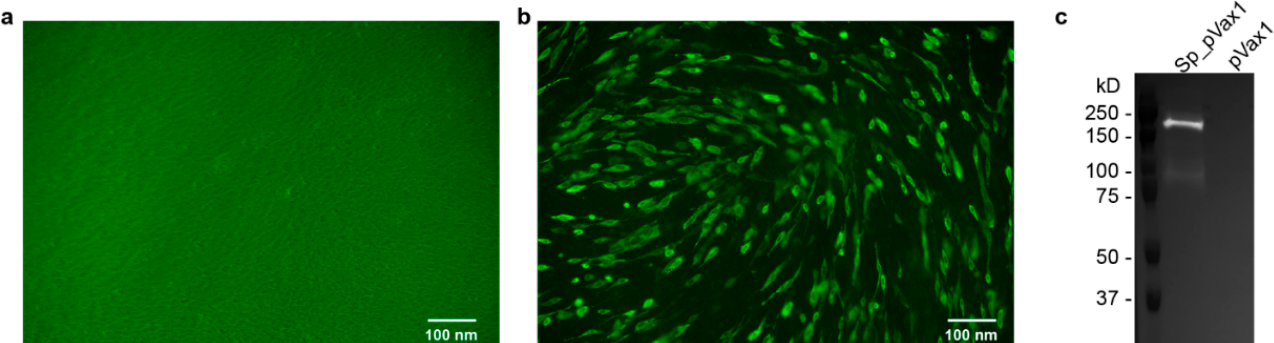
Figure 1. Sp_pVax1 and pVax1 Plasmid Expression. Immunofluorescence assay (IFA) on BHK-21 cells transfected with ( a ) pVax1 or ( b ) Sp_pVax1. Cells were permeabilized and probed with primary anti-V5 antibody and secondary fluorescent antibody at 24 h post transfection to visualize spike protein-positive cells. BHK cell lysate was collected at 24 h post transfection and evaluated via ( c ) western blot to detect appropriately sized spike protein at 180–200 kDa (upper bright band) and cleavage product (lower light band).